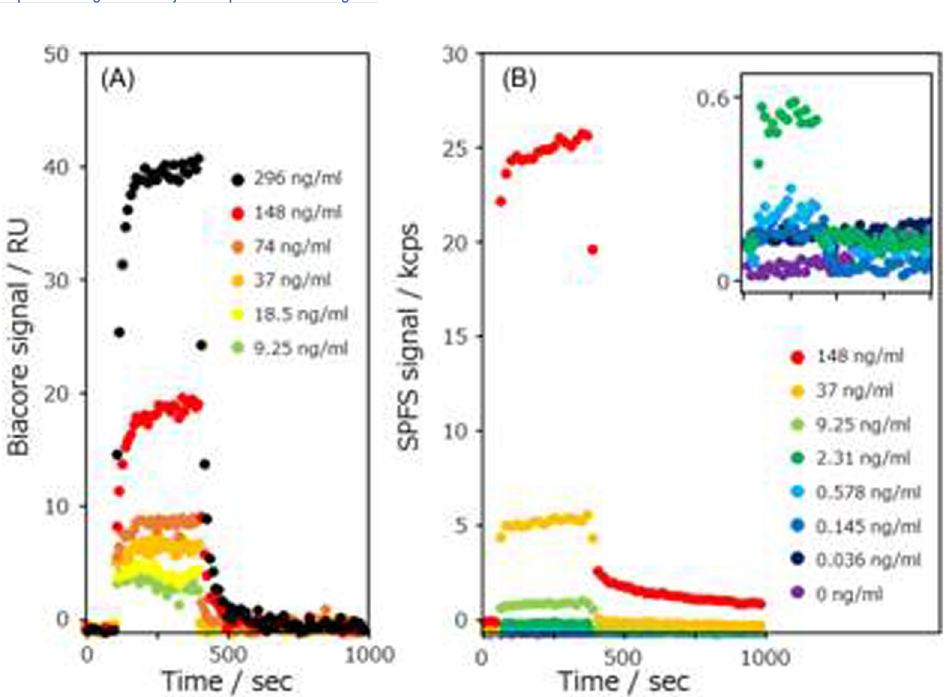
Fig 6. Affinity curves of anti-lysozyme sdAb Y52A mutant. (A) Time course curve of the Biacore system and (B) GC-SPFS fluorescence signal of the difference between the p- and s- polarizations with the lysozyme immunoassay by using the Alexa-647-labeled Y52A mutant.